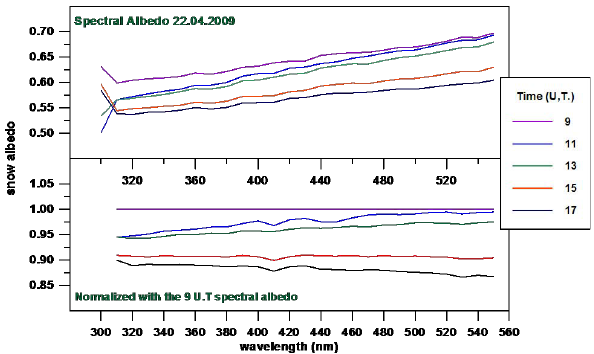
Fig. 4. The snow albedo increased as a function of wavelength. (Up- per panel) Spectral snow albedo for 22 April for different periods during the day. (Lower panel) Ratio of each of the above spectral measurements to the 09:00UTC